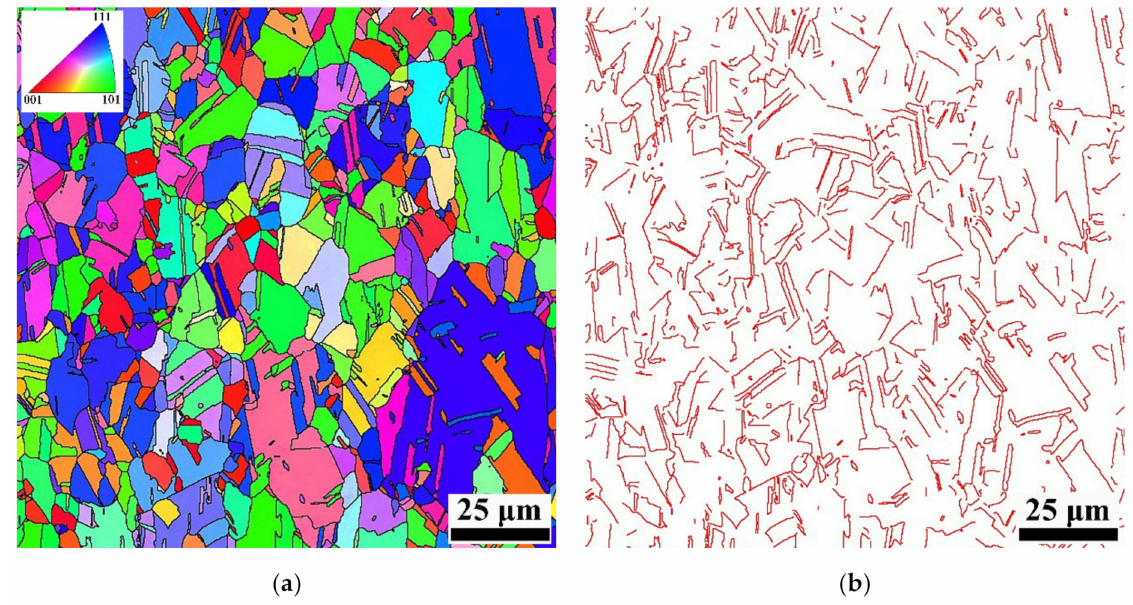
Figure 4. EBSD images of the solutionized specimen: ( a ) inverse pole figure superimposed with grain boundaries and ( b ) map of ∑ 3 twin